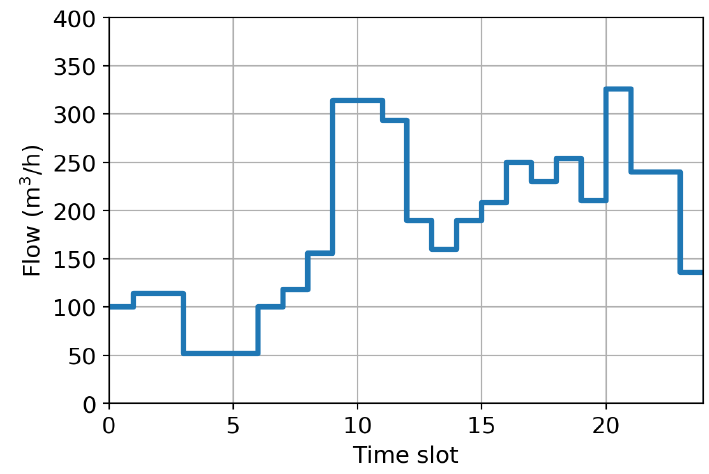
Figure 4. Profile of hourly water demands.